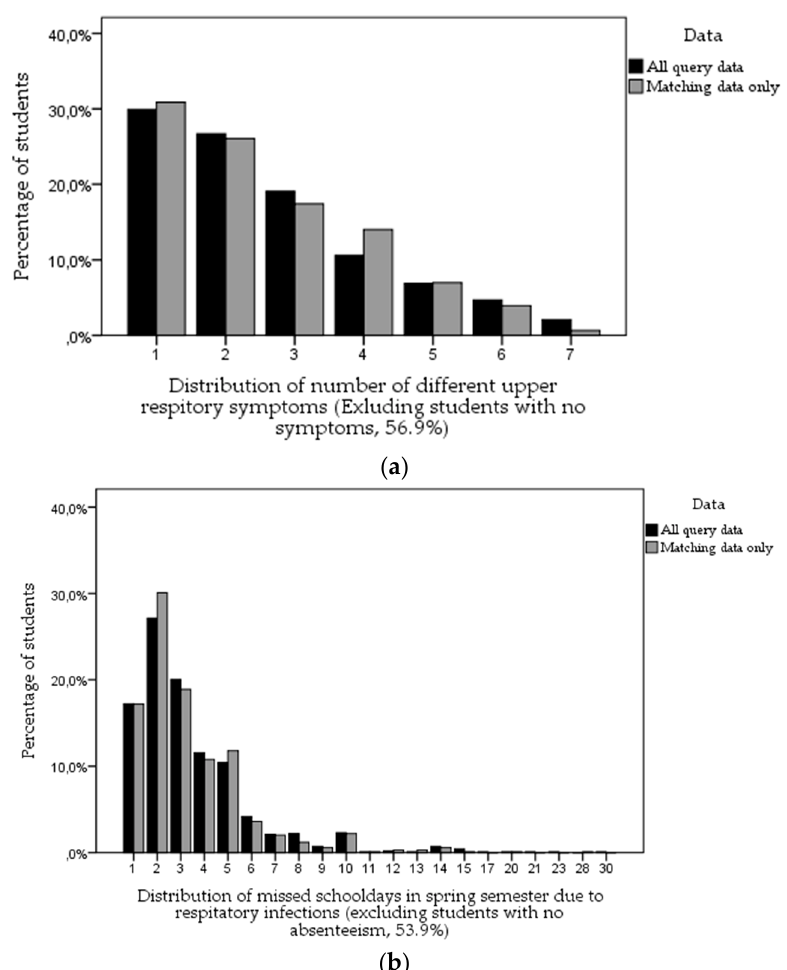
Figure 2. ( a ) Distribution of number of upper respiratory symptoms; ( b ) Distribution of missed school days due to respiratory infections.